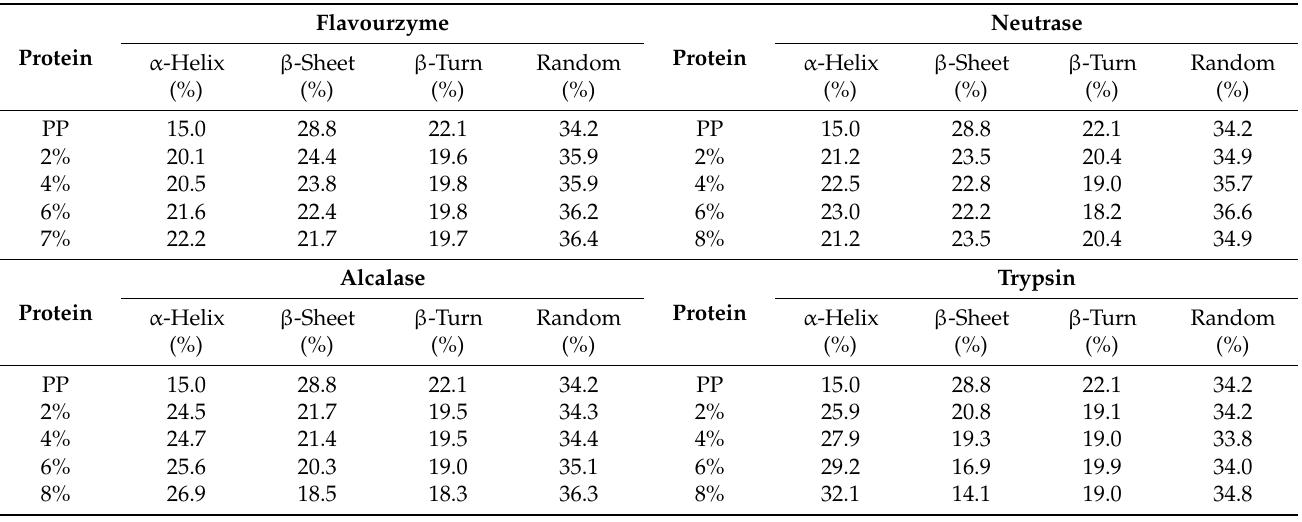
Table 1. Secondary structure content of PP and PP with different DH samples determined by circular